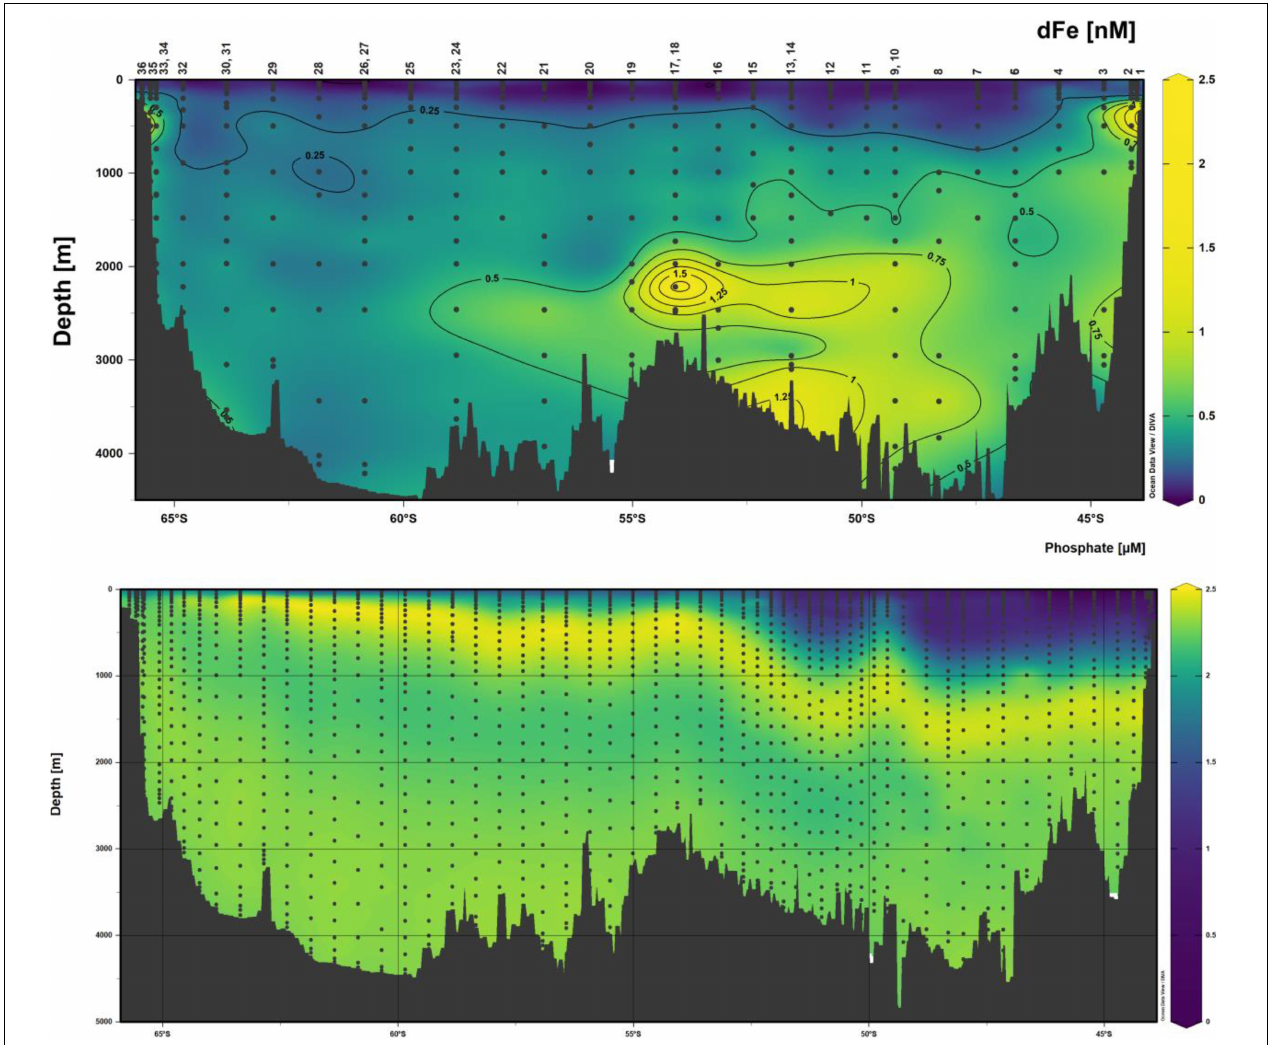
FIGURE 3 | The distribution of dFe (nM, upper ) and PO 4 ( µ M, lower ) along the GS01 section from Antarctica (left) to Tasmania (right) , highlighting the strong enrichment in dFe over the circum-Antarctic ridge between around 52 and 55 ◦